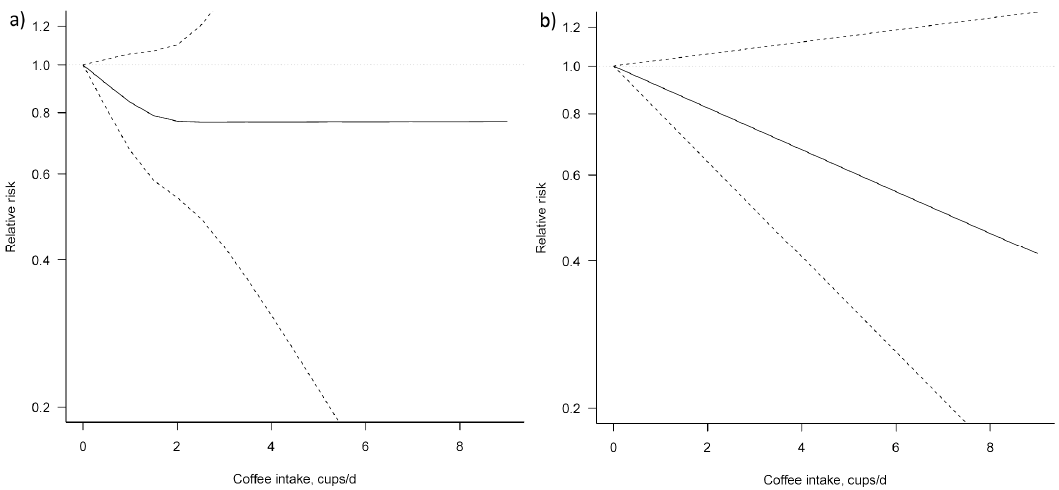
Figure 4. Dose–response association between coffee consumption and BTC risk ( a ) non-linear; ( b ) linear. Solid lines represent relative risk, dashed lines represent 95% confidence intervals.